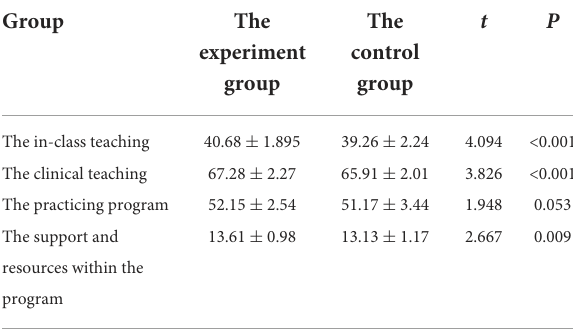
TABLE 3 The comparison of the academic satisfaction with the internship between the two groups of intern nursing students after the internship.